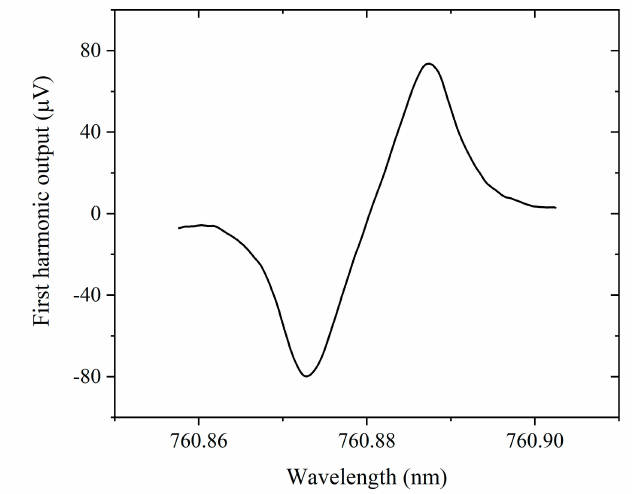
Figure 5. First harmonic output signal for ~20.8% oxygen in